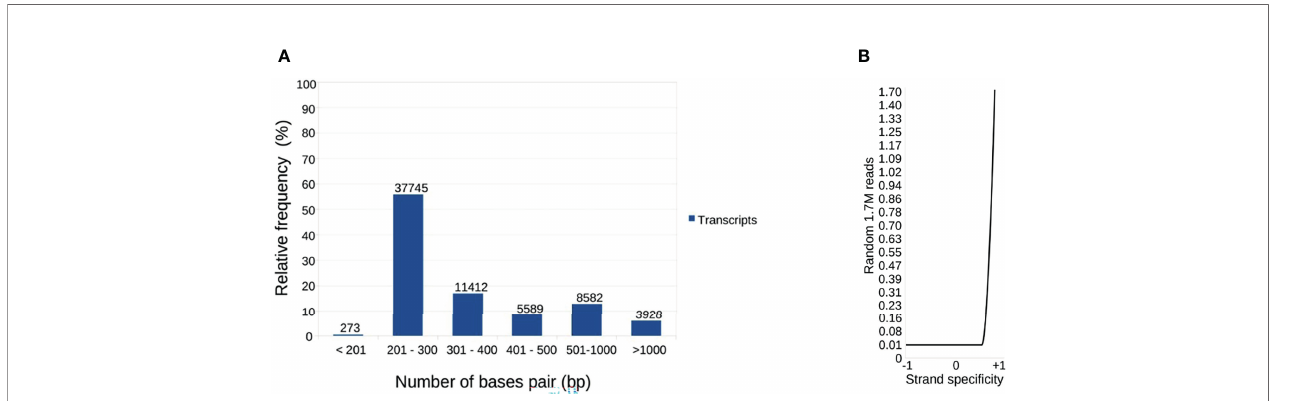
FIGURE 1 | Distribution of nucleotide sequences considered for global reference. (A) The transcripts were distributed according to the bp. A total of 67,529 transcripts were assembled from 37,873,676 paired-reads of the salivary gland and intestine. The distribution shows that the majority (55% approximately) has between 201-300 bp. Minimum size: 133 bp; Maximum size: 28,047 bp. (B) Distribution of the reads used in the assemblies, according to the reading direction evaluated by the Oyster River Strand Exam Tool. Average: